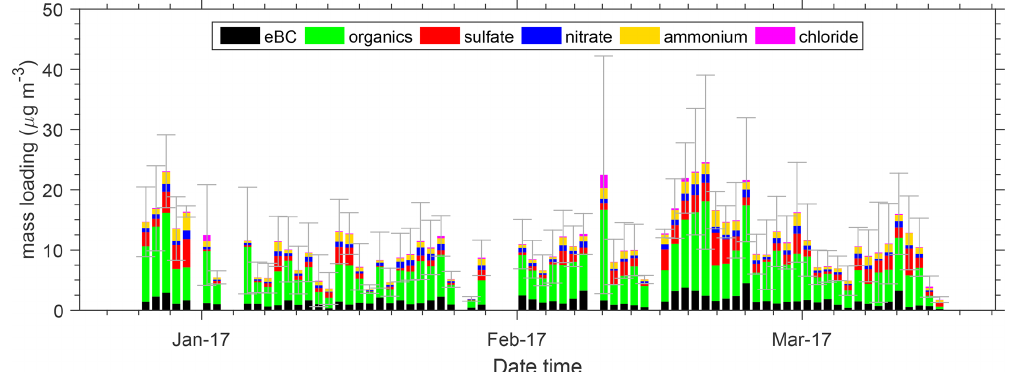
Figure 2. Time series of mass concentration of PM 1 chemical species. Each bin represents 1d average of measured data. The error bars represent the SD of the sum of all components.